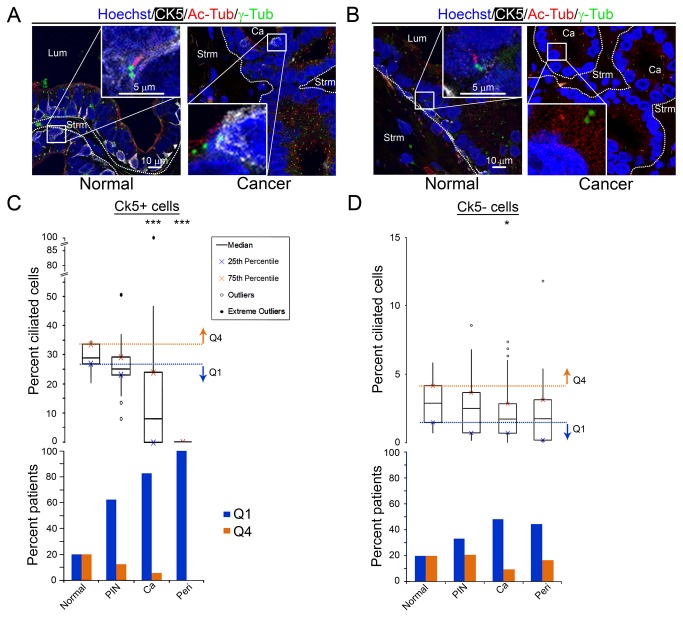
Primary cilia frequency is decreased on both CK5+ and CK5- cancer cells.Images of normal prostate and invasive prostate cancer. Nuclei (Hoechst; blue), cytokeratin 5 (CK5; white), primary cilia (Ac-Tub; red) and centrosomes (γ-Tub; green) are labeled. (A) CK5 marks the basal cell population in normal tissue. (A, left) A ciliated CK5+ normal cell and (A, right) an unciliated CK5+ cancer cell are shown at higher magnification. (B, left) A ciliated CK5- normal cell, and (B, right) an unciliated CK5- cancer cell. (C, top) Boxplots of the percent ciliated CK5+ and (D, top) CK5- epithelial and cancer cells per patient for each tissue type: normal, prostatic intraepithelial neoplasia (PIN), cancer (Ca), and perineural invasion (Peri). Q4, Q1 are as in Fig. 1. Statistics were performed using linear regression (*=p<0.05, ***= p<0.001). (C, bottom) Percent of CK5+ and (D, bottom) CK5- patients with an abnormally high percent cilia (Q4; orange), or an abnormally low percent cilia (Q1; blue).